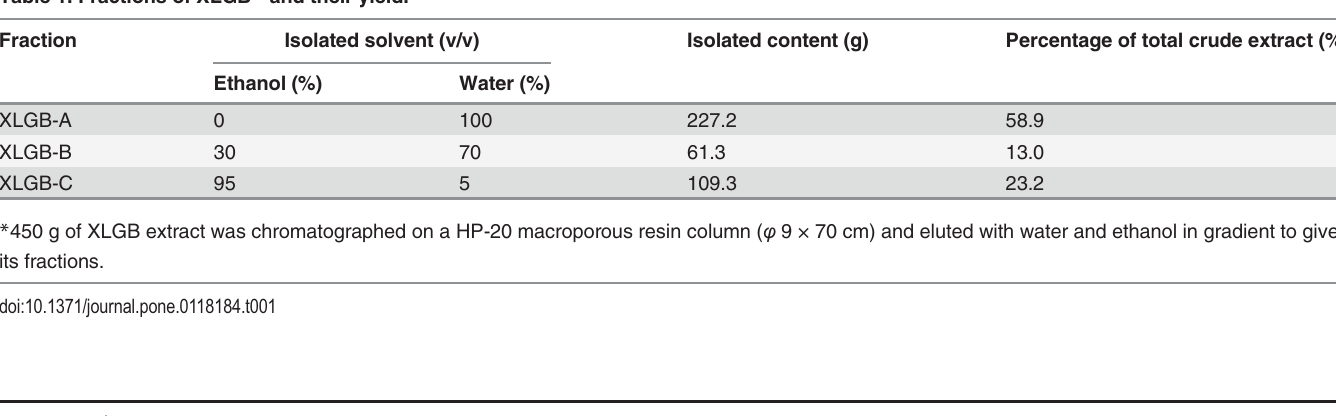
Table 1. Fractions of XLGB * and their